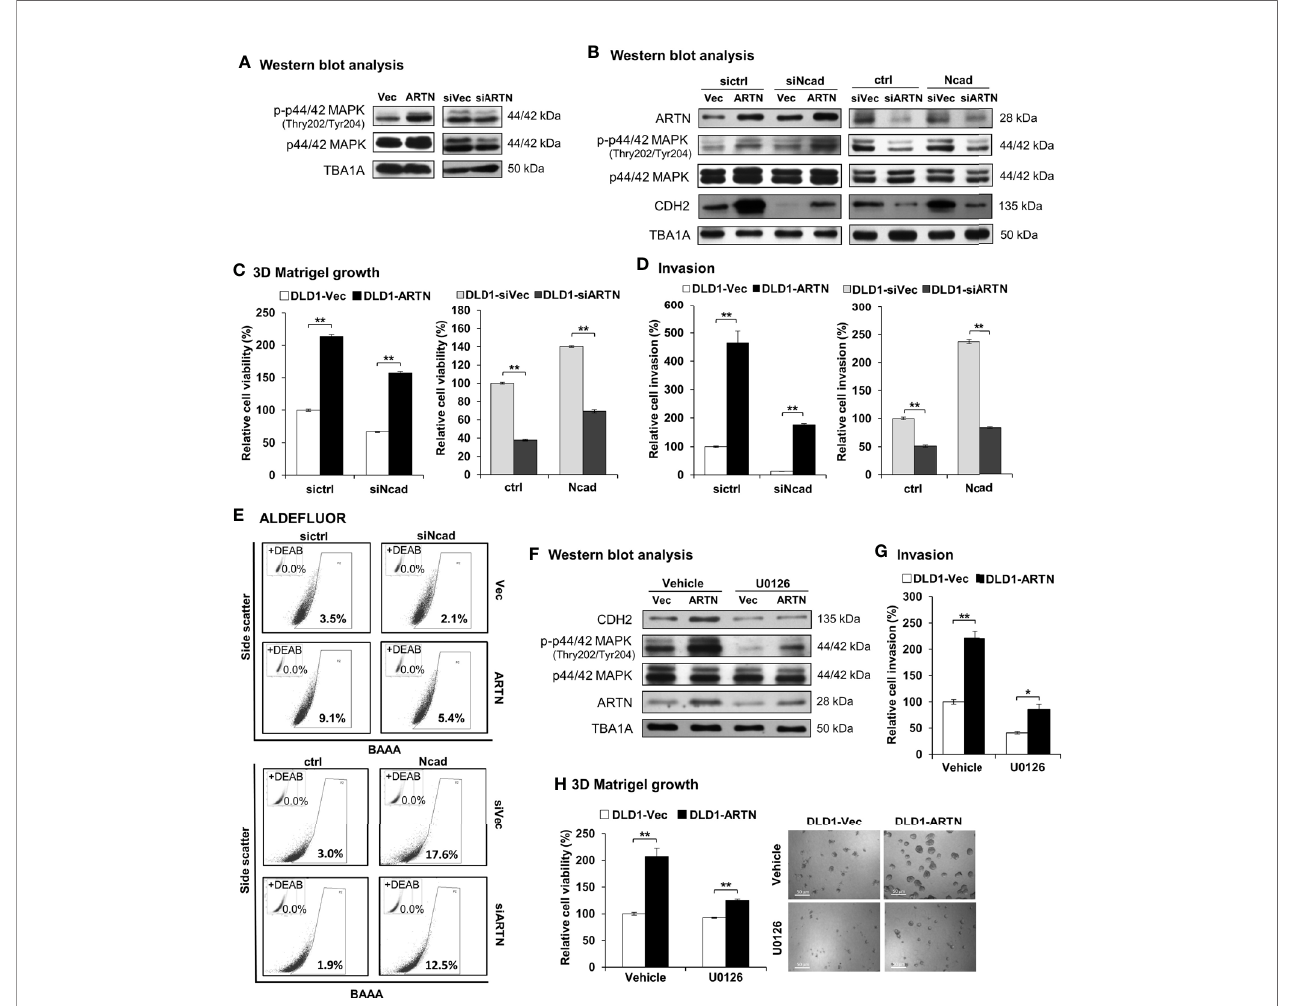
FIGURE 7 | ARTN stimulates its functions through p44/42 MAPK/CDH2 signaling in CRC cells. (A) Western blot analysis for the expression and phosphorylation of p44/42 MAPK in DLD1 cells with stable forced expression or depletion of endogenous ARTN. (B) DLD1 cell pairs were transiently transfected to deplete the endogenous CDH2 (sictrl/siNcad) or to force the expression of CDH2 (ctrl/Ncad), and examined for the expression of CDH2, p44/42 MAPK and ARTN by Western blotting. (C, E) , DLD1 cell pairs were transiently transfected to deplete the endogenous CDH2 (sictrl/siNcad) or to acquire forced expression of CDH2 (ctrl/Ncad), and examined for 3D Matrigel growth (C) , cell invasion (D) , and the population of ALDH1 bright cells (E, F) Western blotting analysis for the expression of CDH2, p44/ 42 MAPK and ARTN in U0126 treated (5µM for 6 hours) DLD1 cells with stable forced expression of ARTN. (G) Invasion of DLD1 cells with stable forced expression of ARTN in the absence or presence of 5µM U0126. (H) 3D Matrigel growth of DLD1 cells with stable forced expression of ARTN in the absence or presence of 5µM U0126 determined for cell viability by Alamar Blue assay. * p < 0.05, ** p <